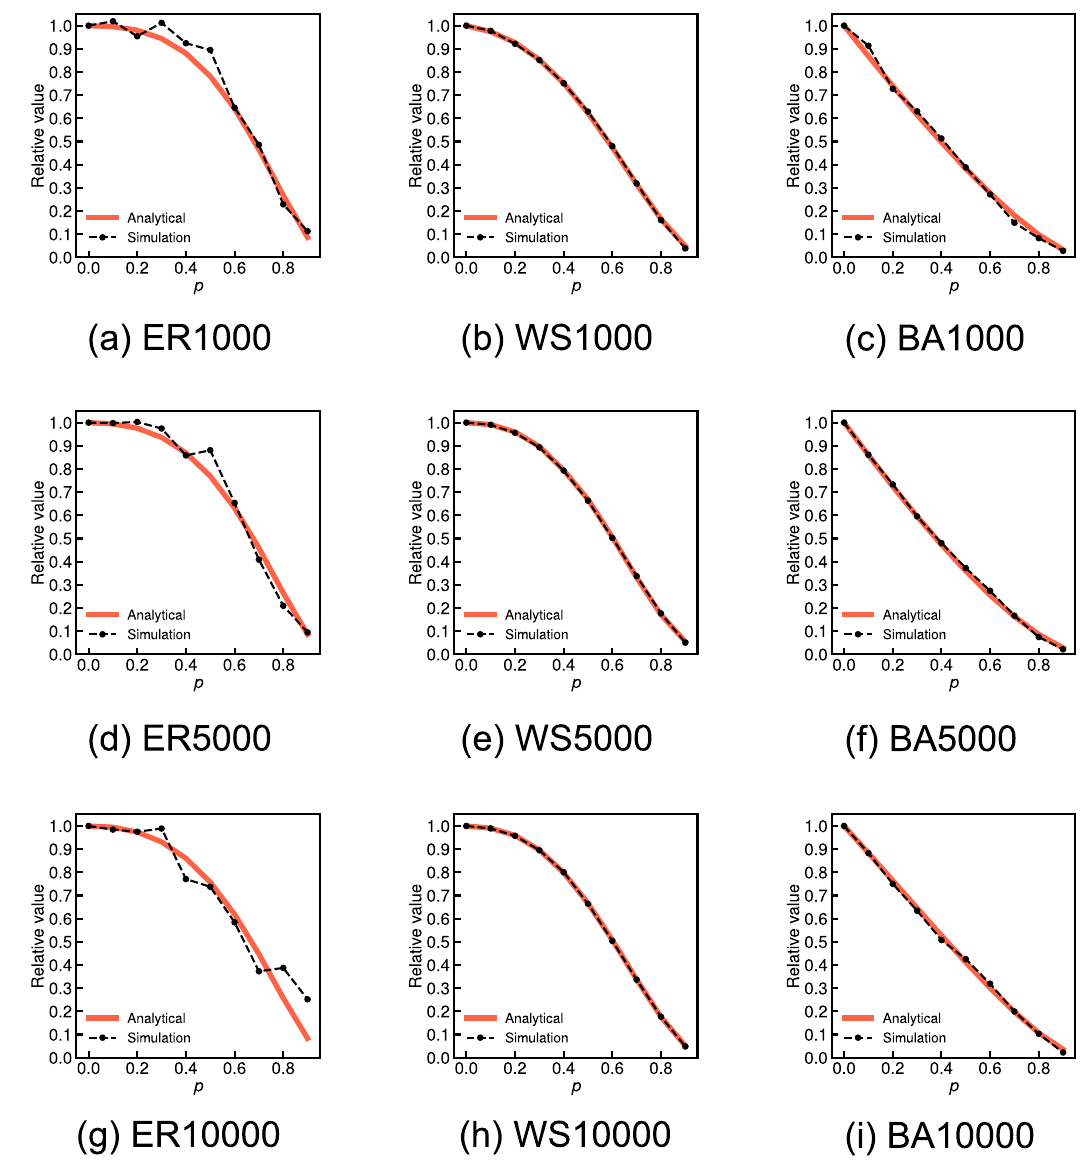
1000, 5000, and 10,000